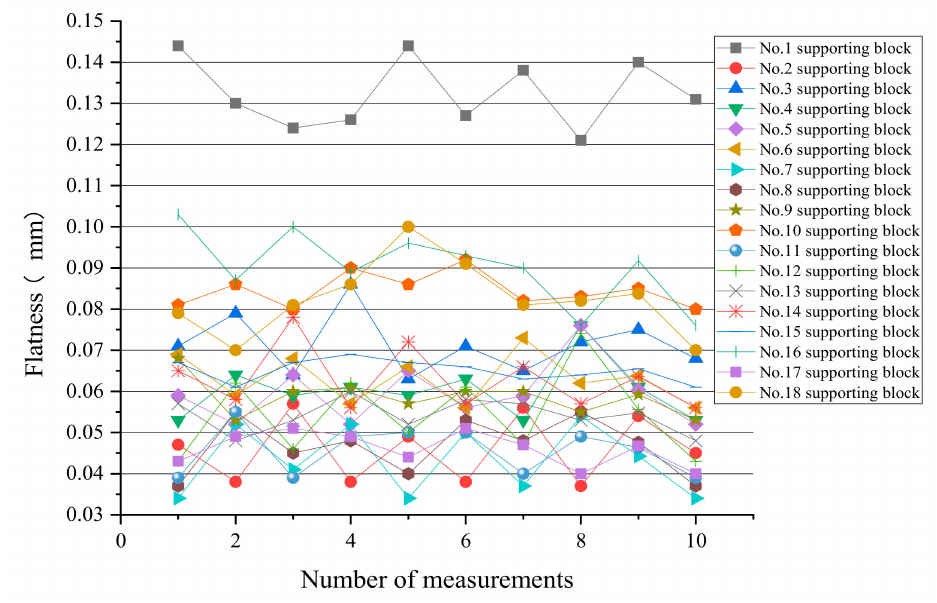
Figure 19. Flatness of repeated measurements.